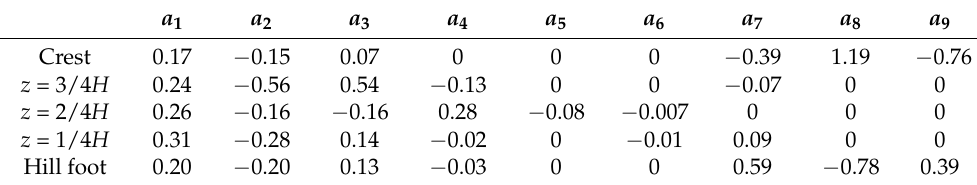
Table 5. Values of a